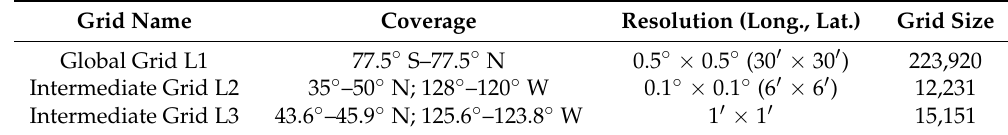
Table 1. Grid information for WAVEWATCH III ®